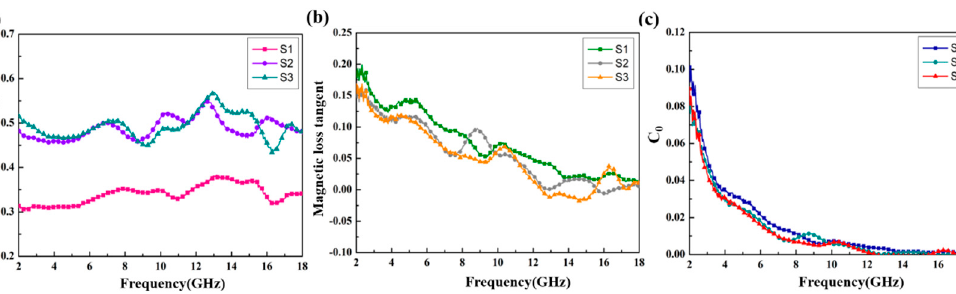
Figure 7. ( a ) Dielectric loss tangent, ( b ) magnetic loss tangent, and ( c ) C 0 –f curves of the samples.